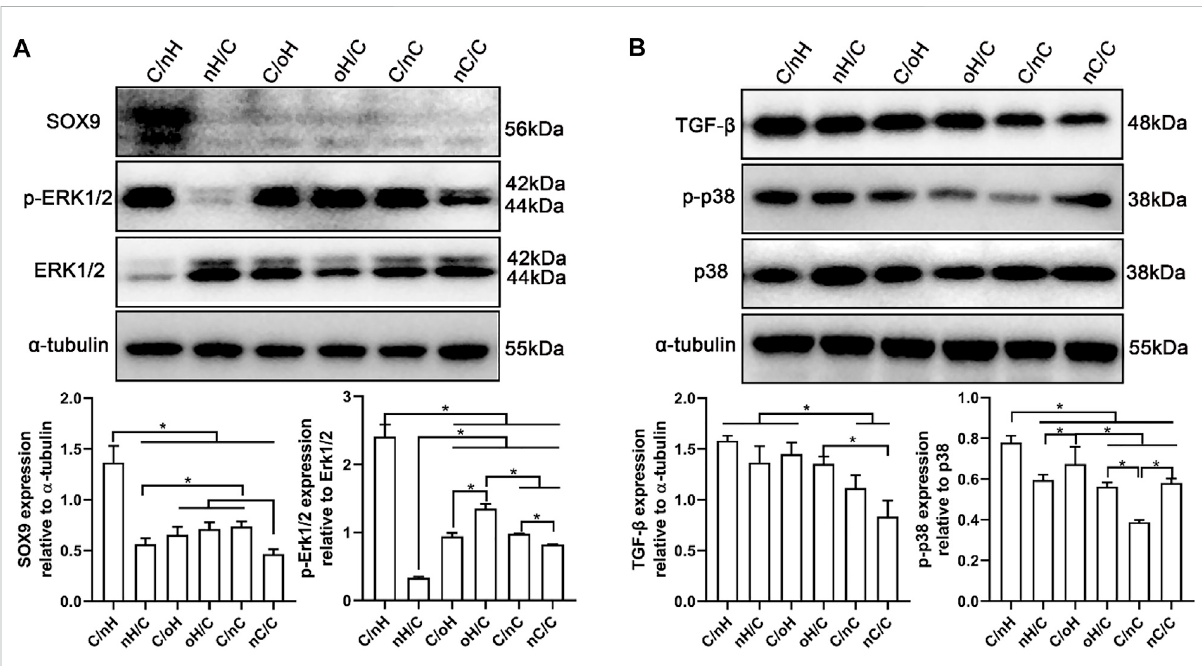
FIGURE 6 ERK/Sox9 and p38 pathways are involved in the multilayers-dependent differentiation of hUC-MSCs (A) Representative blots showing the expression levels ofERK/Sox9 signal pathway involved proteins inhUC-MSCsplaced onthedifferentmultilayer surfaces after21 days ofinductionin chondrogenic differentiation medium and the qualitative data showing the ratios of p-ERK/ERK and Sox9 to tubulin as evaluated by densitometric analysis of western blots. (B) Representative blots showing the expression levels of p38 signal pathway involved proteins in hUC-MSCs placed on the different multilayer surfaces after 21 days of induction in chondrogenic differentiation medium and the qualitative data showing the ratios of TGF- β and p-p38/p38 to tubulin as evaluated by densitometric analysis of western blots. Data are representative and displayed as the mean ± SD of three independent experiments. The multilayers are the same as described in Figure